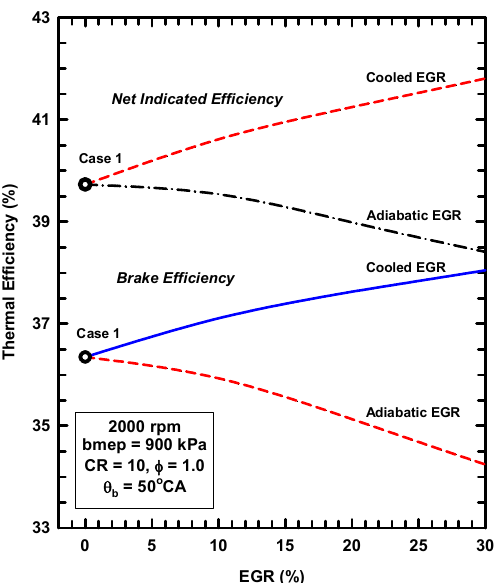
Figure 13. Net indicated and brake efficiencies as functions of the EGR percentage for the two EGR configurations.